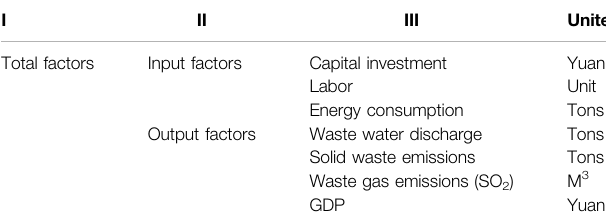
TABLE 1 | The composition of total factors.